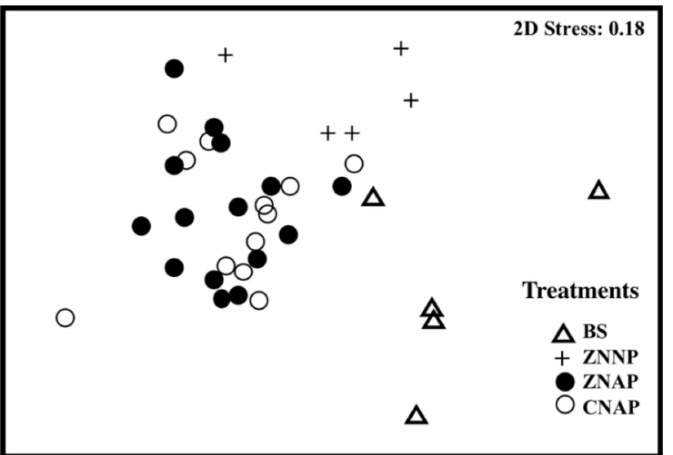
Figure 4. Multidimensional scaling plot of species composition associated with each habitat type. Bare sediment-BS; artificial patches of Zostera noltei -ZNAP, artificial patches of Cymodocea nodosa - CNAP, and natural patches of Zostera noltei